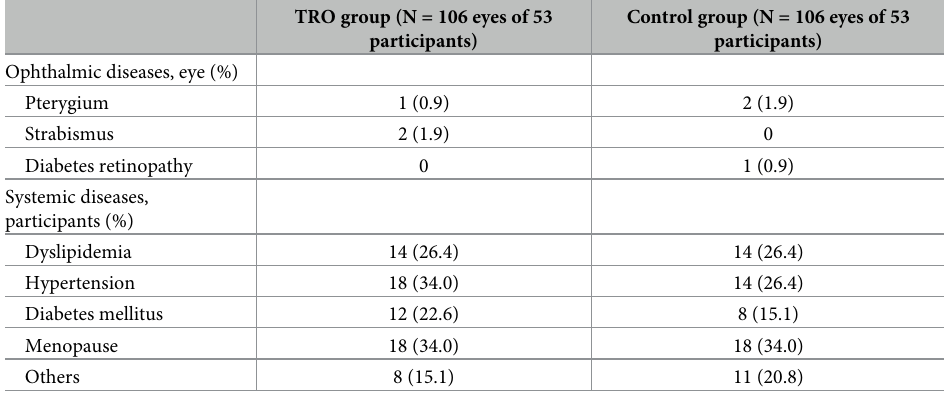
Table 1. The ophthalmic and systemic diseases in thyroid related orbitopathy (TRO) and control groups. TRO group (N = 106 eyes of 53 participants)